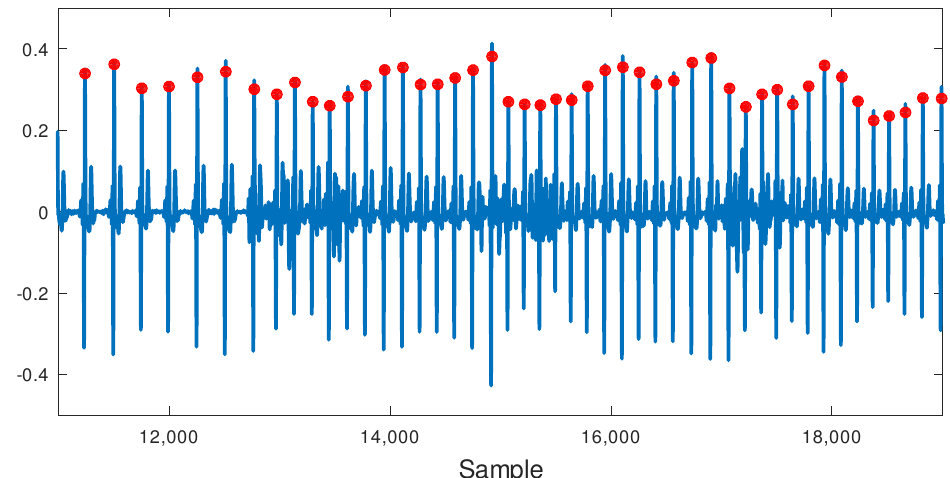
Figure 15. Pan–Tompkins algorithm output (red circles) for an ECG segment including light PA. Motion artifacts do not affect QRS-complex